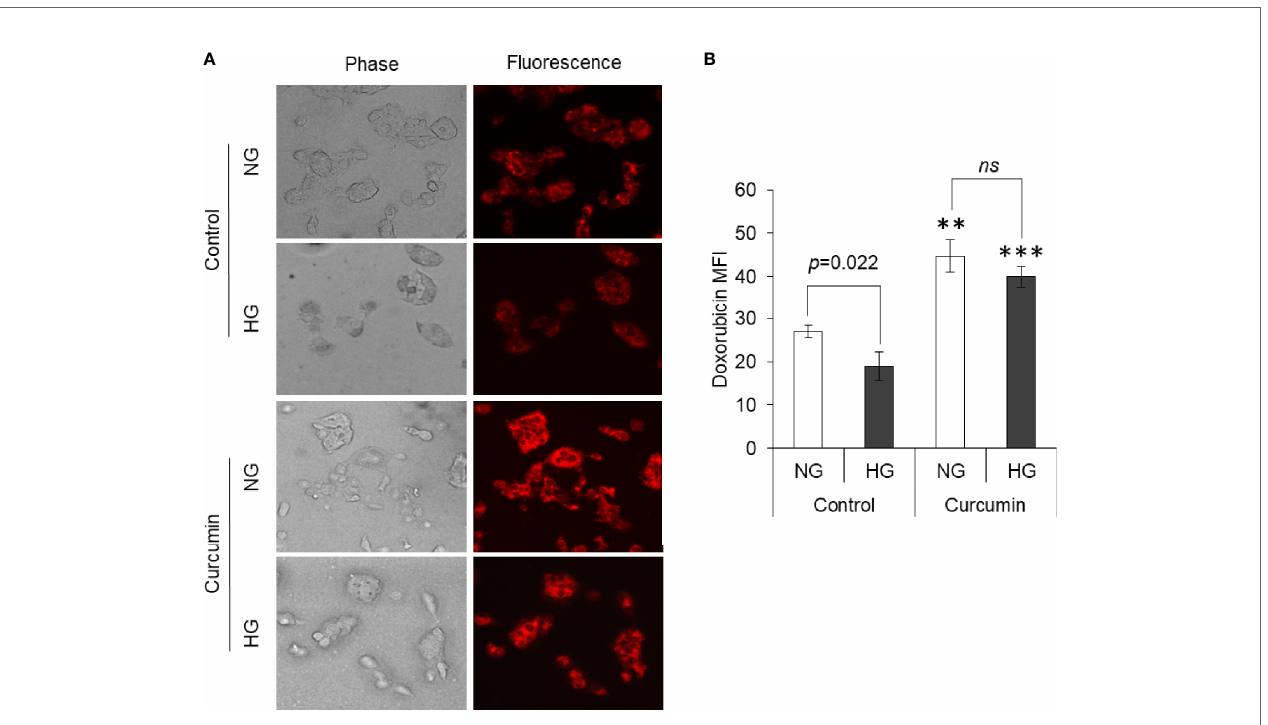
FIGURE 10 | Curcumin promotes intracellular accumulation of drugs. Drug uptake by cells incubated in NG or HG medium alone or containing curcumin was detected. Doxorubicin fl uorescence was detected using fl uorescence microscope (A) . Mean fl uorescence intensity (MFI) of cells was determined (B) . Photomicrographs shown are representative of three experiments conducted independently. The values shown are Mean ± SD of three independent experiments conducted in triplicate. ** p < 0.01, *** p < 0.001 vs values of cells of control group not treated with curcumin. ns, not signi fi